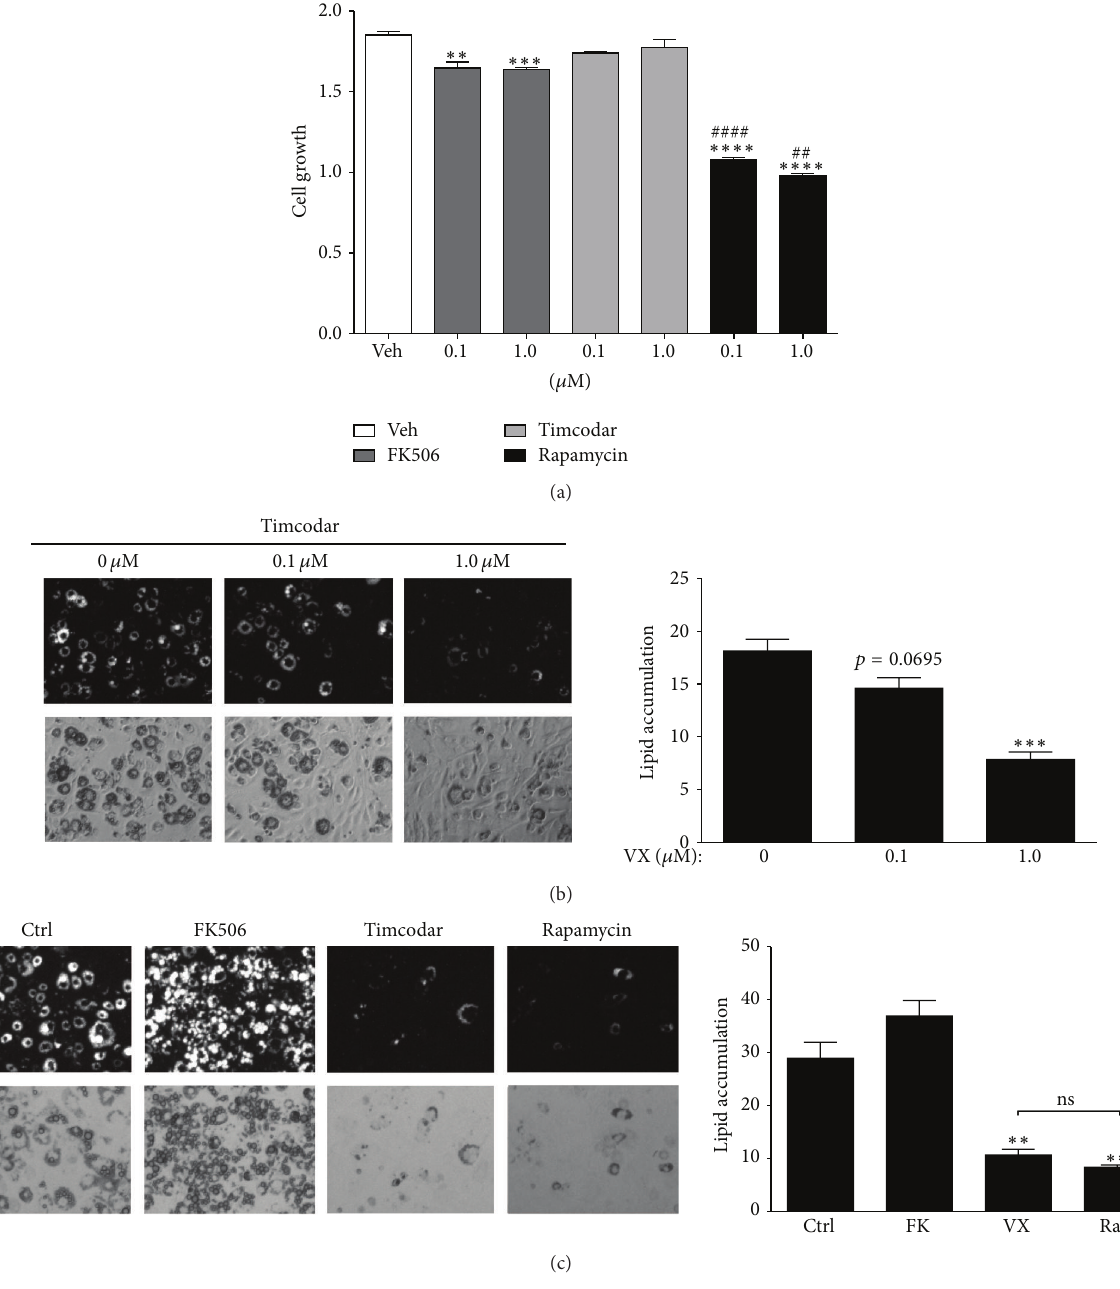
Figure 2: Rapamycin and timcodar reduce lipid accumulation in 3T3-L1 adipocytes. (a) Cell growth of 3T3-L1 cells in regular BCS growth serum for 48 hours with vehicle (Ctrl), 0.1 and 1.0 𝜇 M FK506, 0.1 and 1.0 𝜇 M timcodar, and 0.1 and 1.0 𝜇 M rapamycin (ANOVA, 𝑝 < 0.0001 ). Growth was measured as MTT. ∗∗ 𝑝 < 0.01 ; ∗∗∗ 𝑝 < 0.001 ; ∗∗∗∗ 𝑝 < 0.0001 (versus control); ## 𝑝 < 0.01 ; and #### 𝑝 < 0.0001 (timcodar versus rapamycin treatment) ( ± S.E.; 𝑛 = 4 ). (b) Nile Red staining of lipid accumulation in differentiated 3T3-L1 adipocytes treated with vehicle (0 𝜇 M) and increasing doses of timcodar (VX) (0.1 𝜇 M or 1.0 𝜇 M); ∗∗∗ 𝑝 < 0.001 (versus control) ( ± S.E.; 𝑛 = 3 ). (c) Comparison of lipid accumulation of differentiated 3T3-L1 adipocytes treated with vehicle (Ctrl), 1 𝜇 M FK506 (FK), 1 𝜇 M timcodar (VX), and 1 𝜇 M rapamycin (Rap); ∗∗ 𝑝 < 0.01 (versus control) ( ± S.E.; 𝑛 = 3 ).